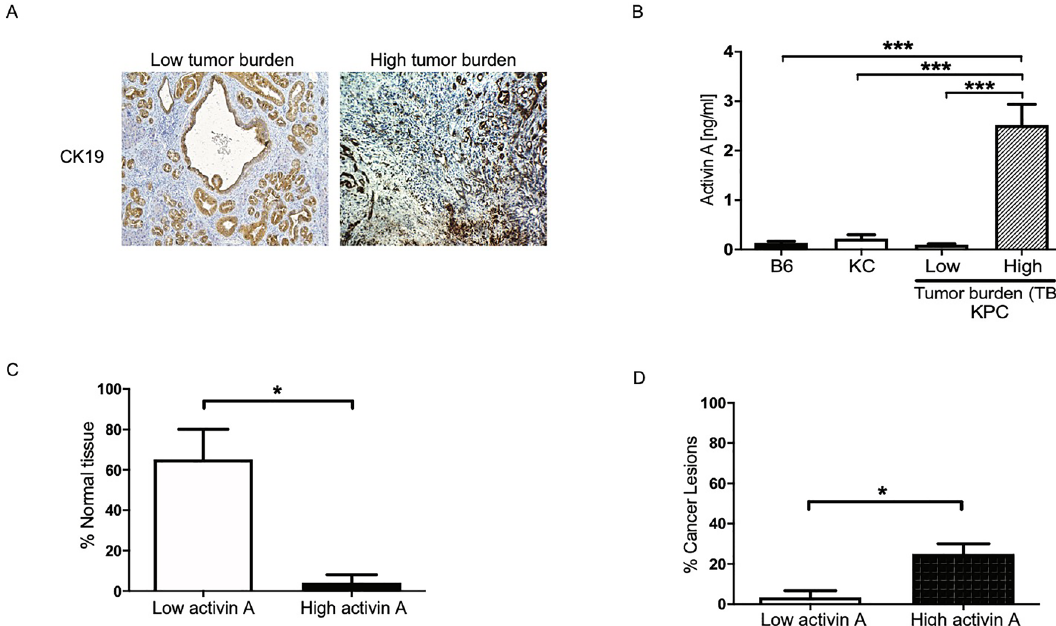
mice (B6 = C57BL6), neoplastic lesion model (KC) and PDAC model (KPC). *** (p < 0.001). Pictures taken at 10 × magnification field. Graph Bars expressed as mean ± SEM. Statistical analysis unpaired Student t-test. ( C ) Normal epithelial pancreatic tissue fraction in low (0 to 0.99 ng/ml) versus high (1.0 to 4.0 ng/ml) activin A expression in serum of KPC mice, *(p = 0.0158). ( D ) Cancerous pancreatic lesion percentage in low versus high activin A expression in serum of KPC mice, *(p =